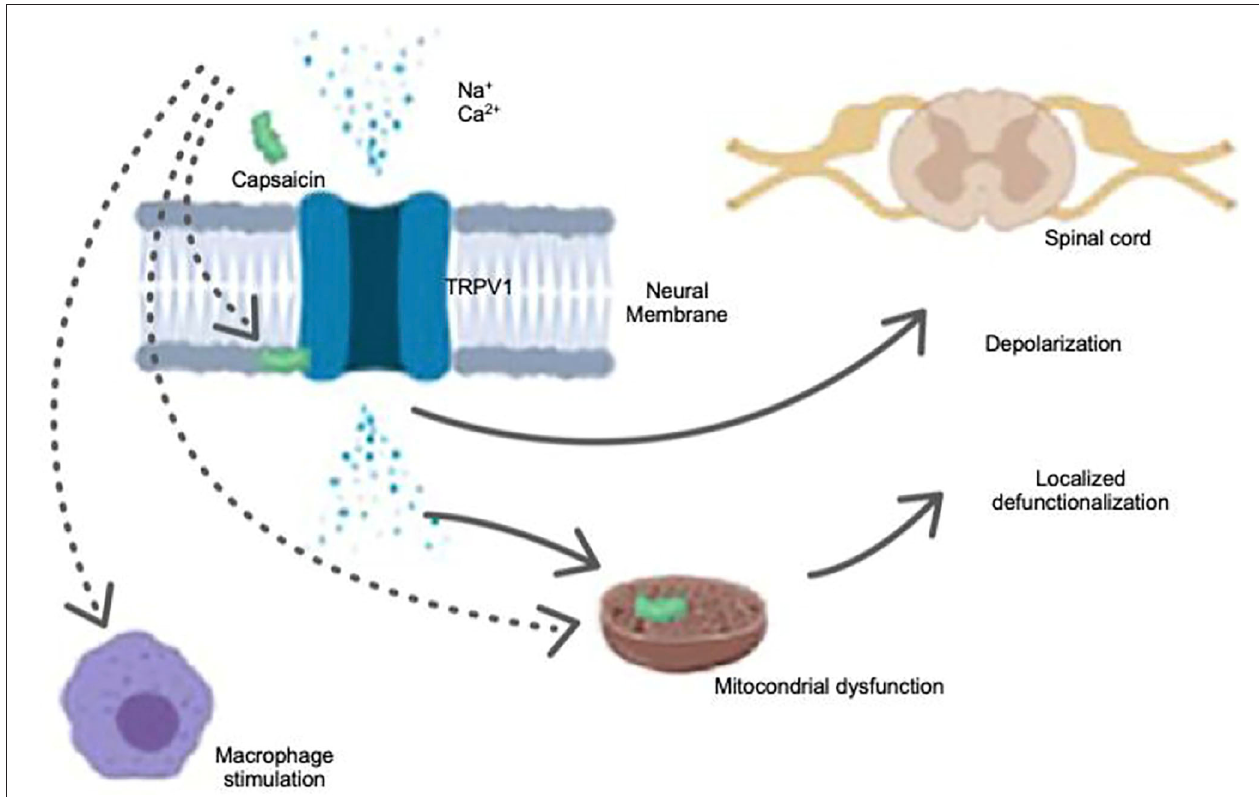
FIGURE 2 | Capsaicin effect in TRPV-1